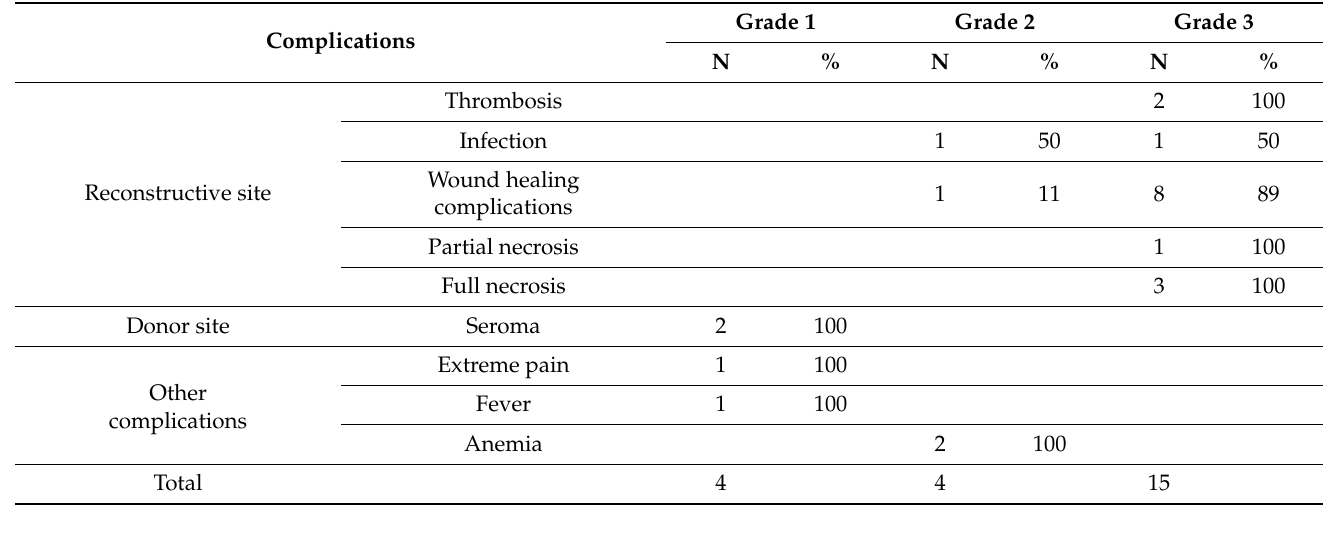
Table 3. Postoperative complications.